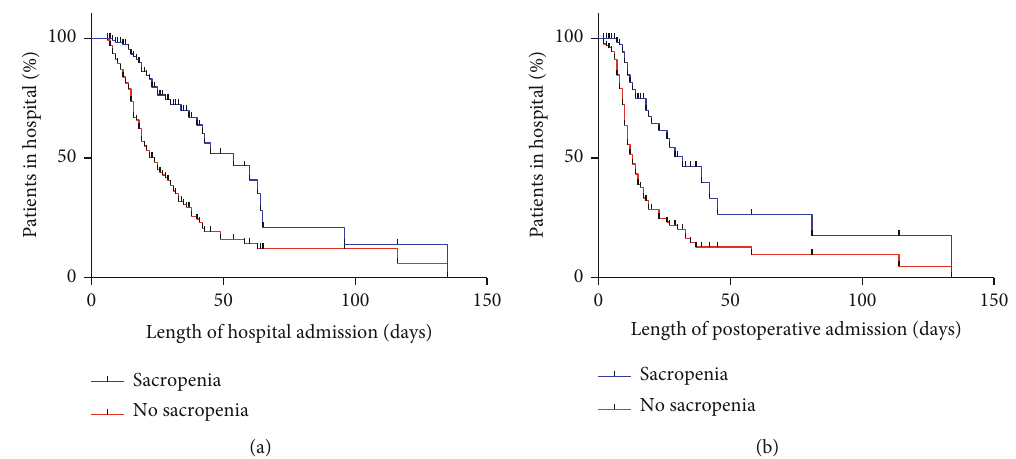
Figure 2: Length of overall hospital stay and postoperative hospital stay dependent on with or without sarcopenia. (a) Length of overall hospital stay ( 34 : 41 ± 26 : 83 vs. 22 : 79 ± 15 : 59 days, P = 0 : 003 ). (b) Length of postoperative hospital stay ( 22 : 47 ± 24 : 73 vs. 14 : 08 ± 13 : 72 days, P = 0 : 018